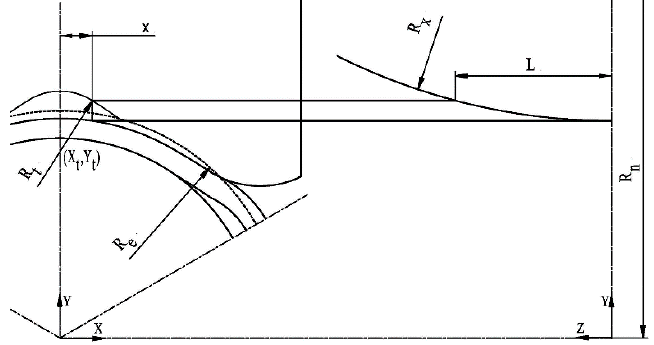
Figure 2. Geometrical relationship on the contact length corresponding to the first formation stage.